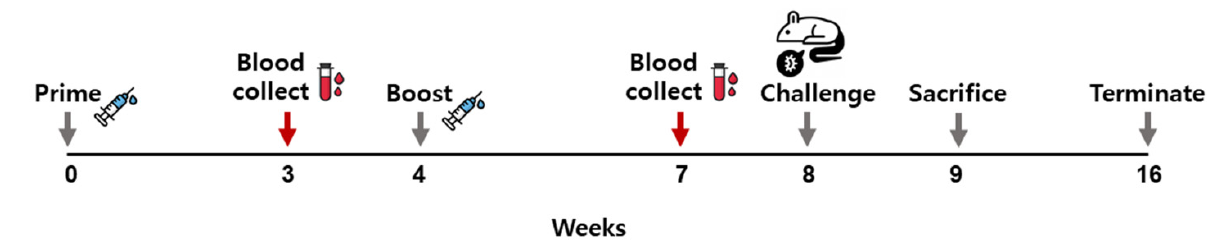
Figure 1. VLPs characterization. MSP-8 ( A ), MSP-9 ( B ) and RAP1 ( C ) VLP morphologies were visualized under TEM. MSP-8 ( D ), MSP-9 ( E ) and RAP1 ( F ) VLPs were loaded (8, 40 µg) for SDS-PAGE, and bands corresponding to each antigen were observed using either the polyclonal P. berghei antibody or the monoclonal M1 antibody.